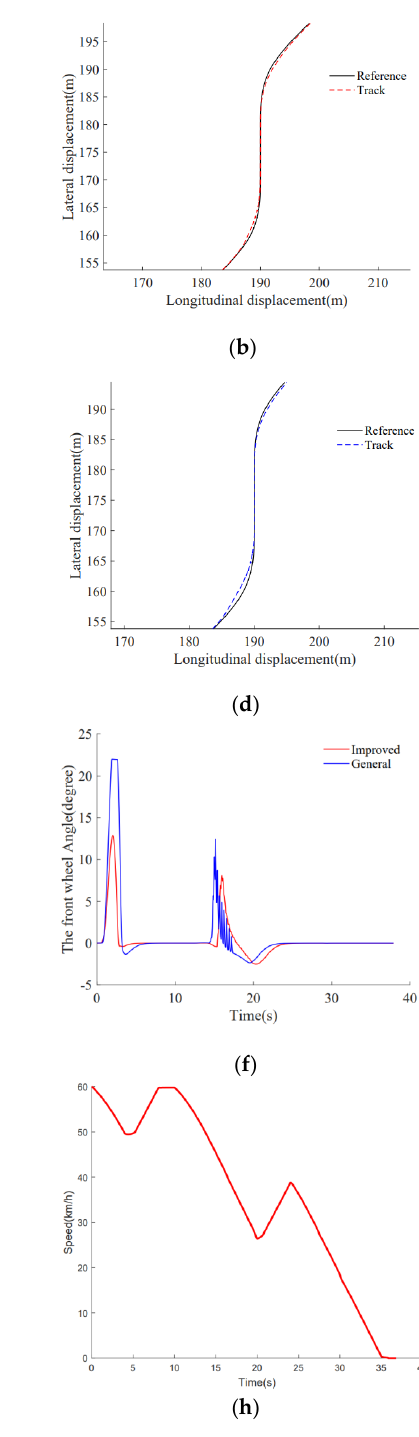
Figure 12. Data image: ( a ) Improved trajectory tracking; ( b ) local enlarged view of improved trajectory tracking; ( c ) general trajectory tracking; ( d ) partial enlarged view of general trajectory tracking; ( e ) lateral deviation; ( f ) front wheel turning angle; ( g ) slip angle of centroid; ( h ) speed.